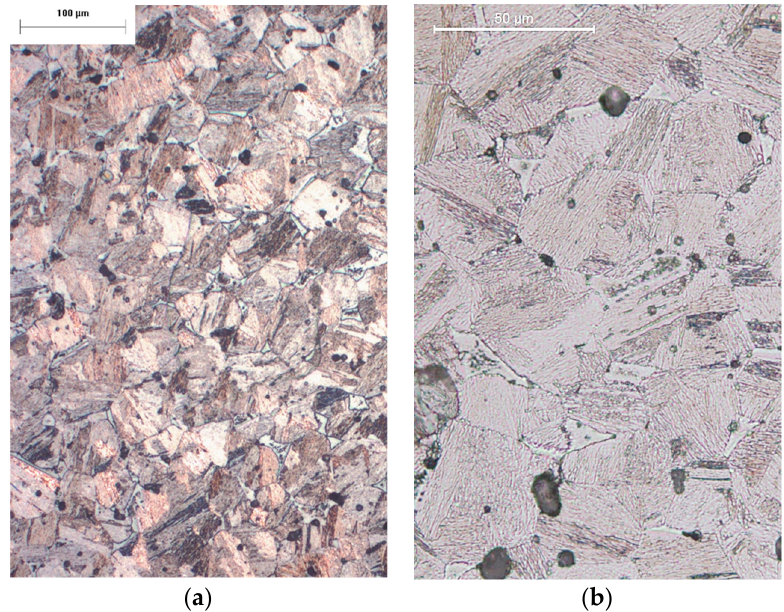
Figure 9. Optical micrographs of the microstructure of the D1 steel after ageing (H1150). Cavities can be easily discerned; the subfigures ( a ) and ( b ) show the microstructure at two different magni- fications.